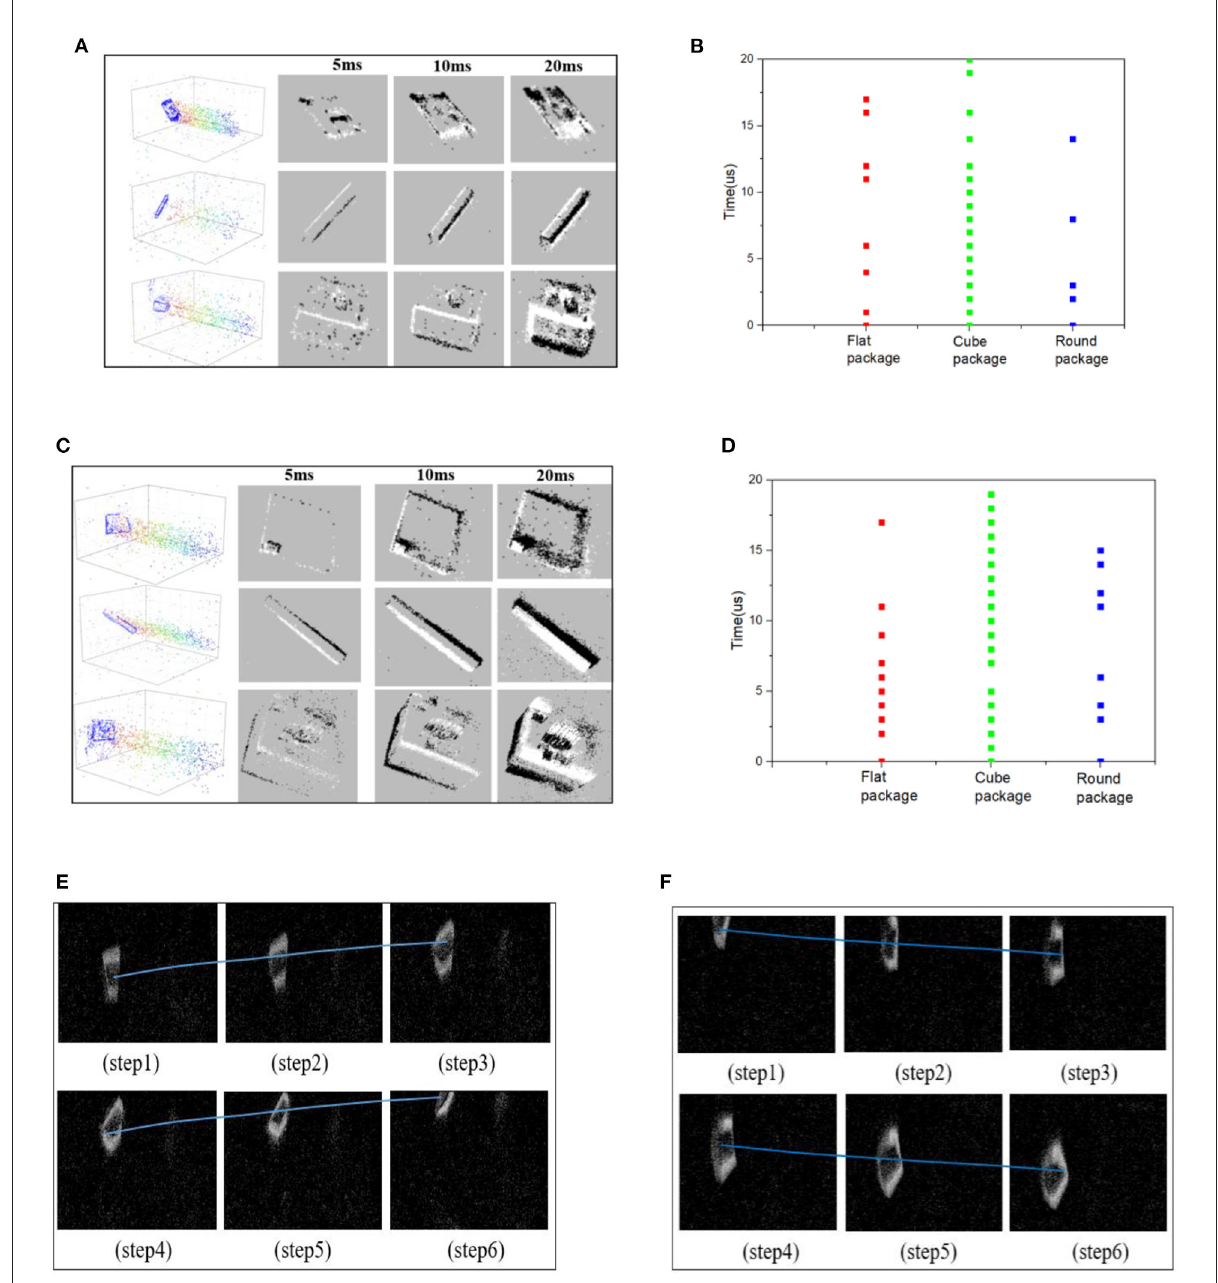
FIGURE4 (A) The event points and encoded frames of recognition dataset. (B) The event thickness of recognition dataset. (C) The event points and encoded frames of falling dataset. (D) The event thickness of falling dataset. (E) The up-thrown experiment process with a falling angle of (0 ◦ ∼ 90 ◦ ). (F) The down-thrown experiment process with a falling angle of ( − 90 ◦ ∼ 0 ◦ ).